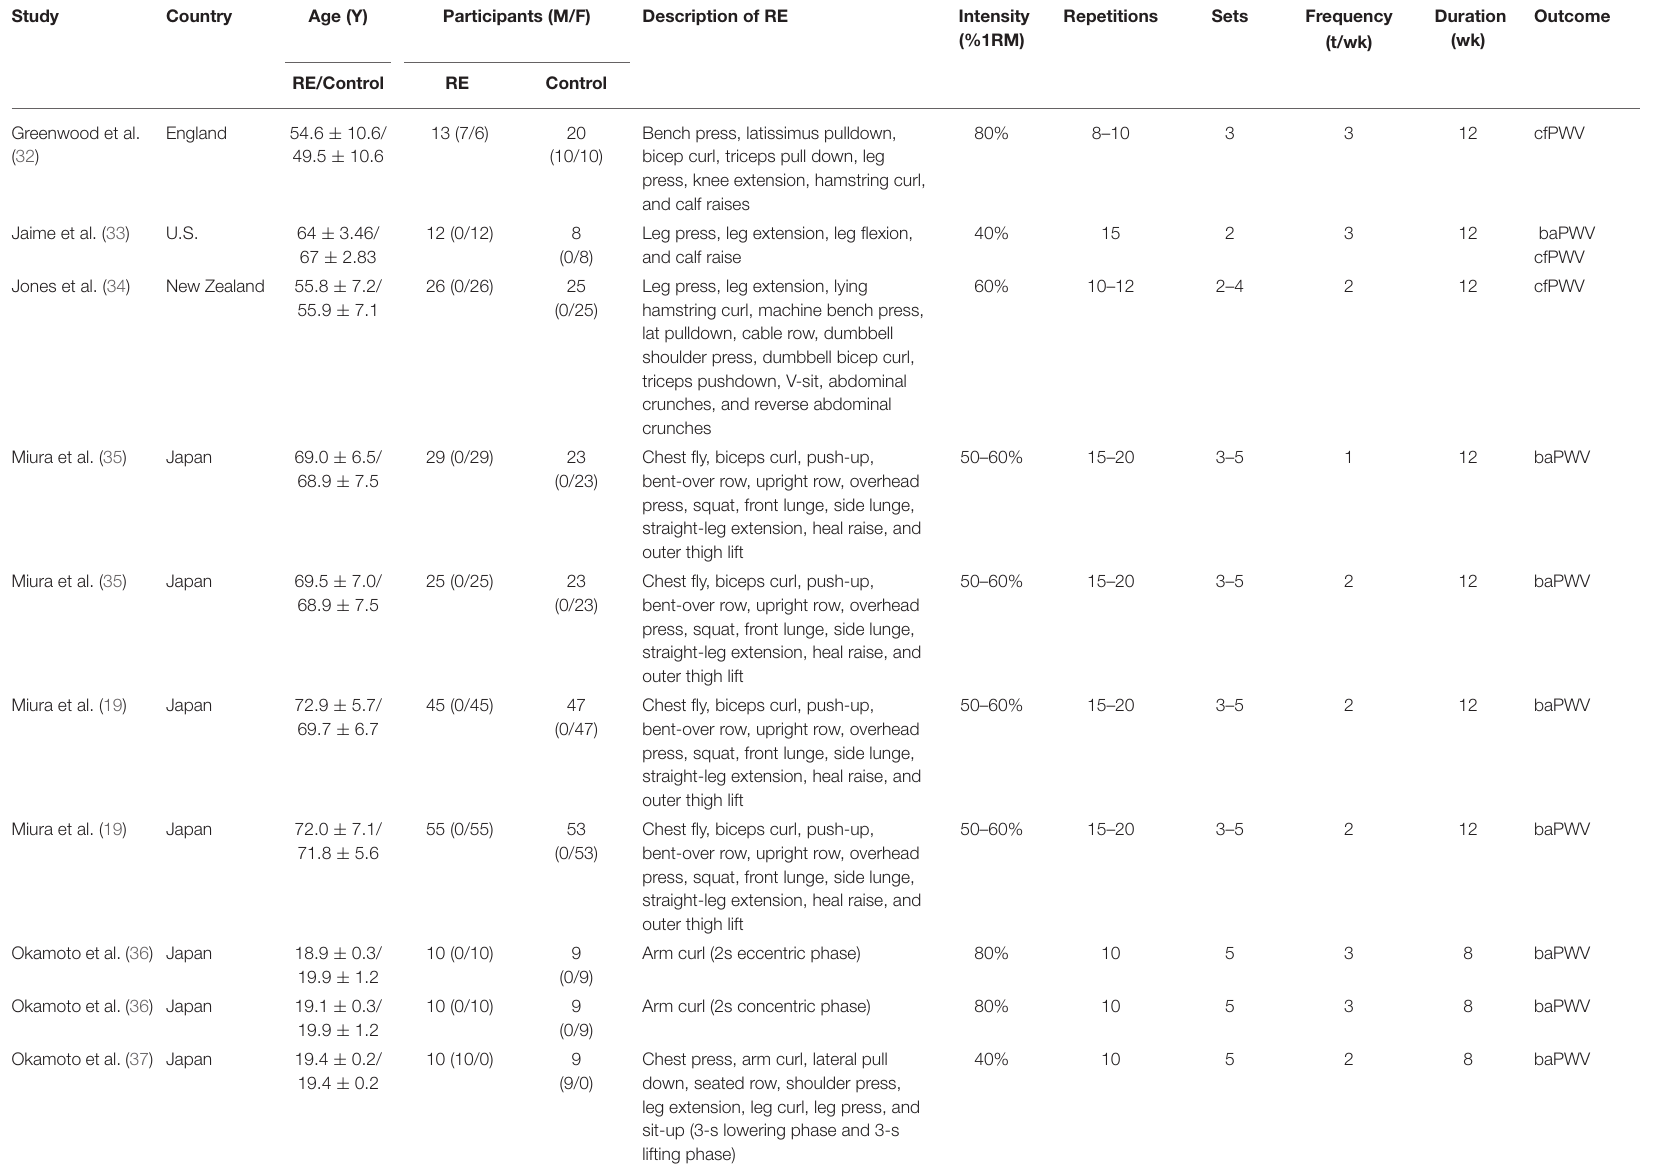
Leg press, leg extension, lying hamstring curl, machine bench press, lat pulldown, cable row, dumbbell shoulder press, dumbbell bicep curl, triceps pushdown, V-sit, abdominal crunches, and reverse abdominal Chest fly, biceps curl, push-up, bent-over row, upright row, overhead press, squat, front lunge, side lunge, straight-leg extension, heal raise, and outer thigh lift